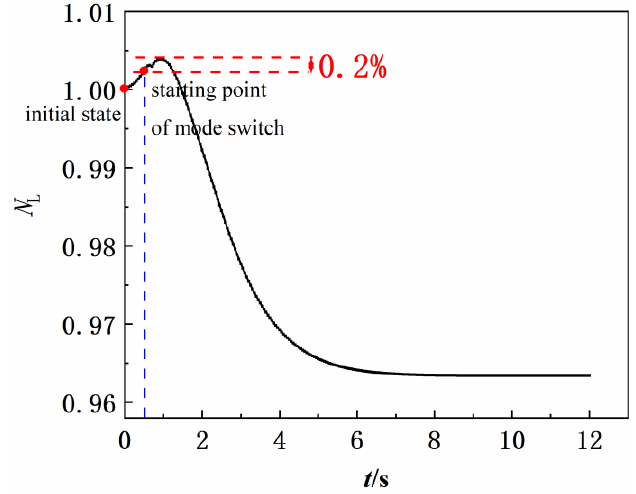
Figure 21. Change curve of low-pressure rotor speed of working-mode switching from single bypass to double bypass at H = 11 km, Ma = 1.2.